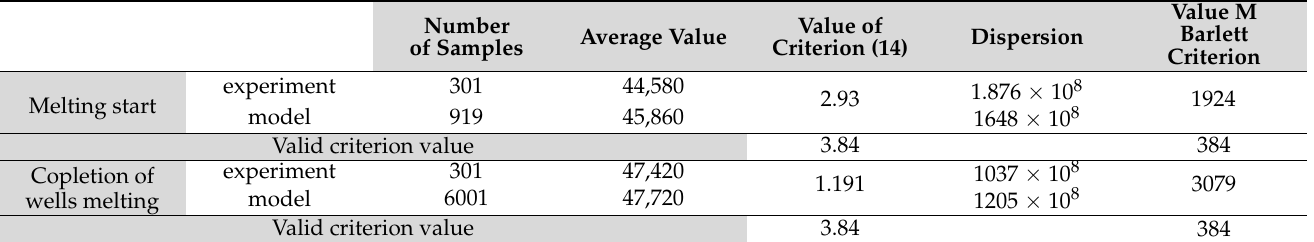
Table 1. Statistical data